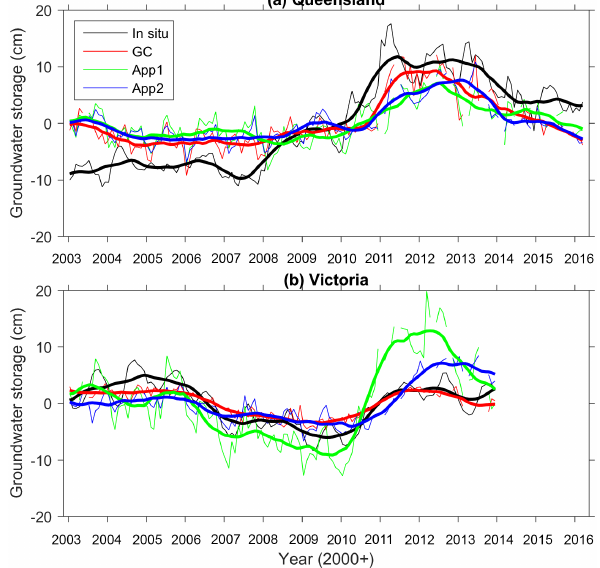
Figure 11. (cid:49) GWS estimated from Approach 1 (App 1) and Ap- proach 2 (App 2) in Queensland (a) and Victoria (b) . The in situ groundwater network data and the GC solutions are also shown. Deseasonalized time series are shown in thick